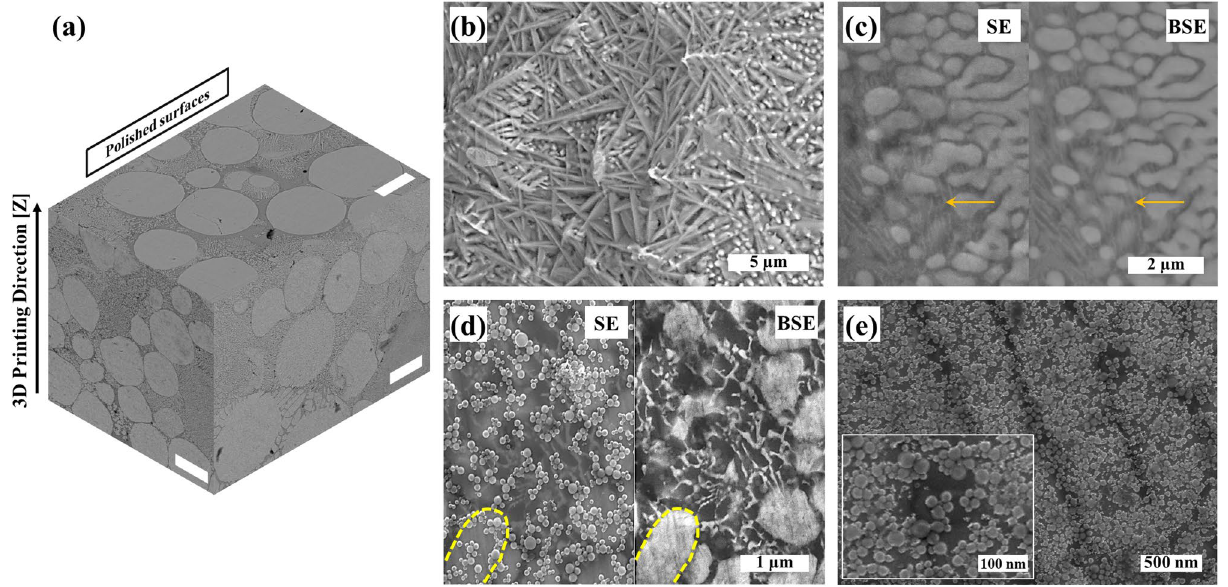
Figure 2. SEM micrographs of (a) polished surfaces of SLM-Mo (x) S (x+1) (scale bar = 25 µm), (b) unpolished top- surface including laser-assisted exfoliated 1T-MoS2 nanosheets and Mo 2 S 3 nanoparticles, (c) high magnification secondary and backscattered electron micrographs acquired from the polished cross-section in which the arrows indicate thin transparent 1T-MoS 2 layers alongside coalesced Mo 2 S 3 nanoparticles, (d) HR-SEM micrograph of the polished surface of SLM-Mo (x) S (x+1) in which the yellow dashed lines indicate coalescence zones of